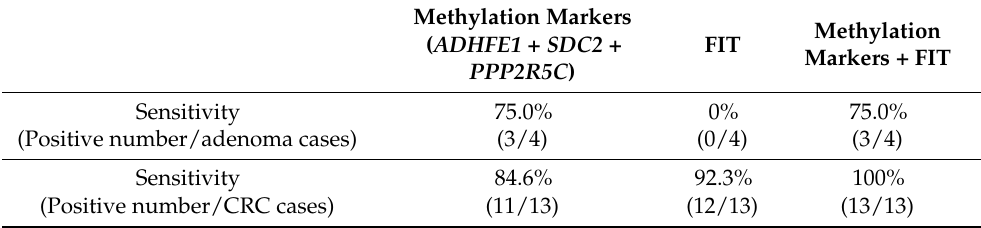
Table 4. The combined performance of methylation markers and FIT for detection of CRC and